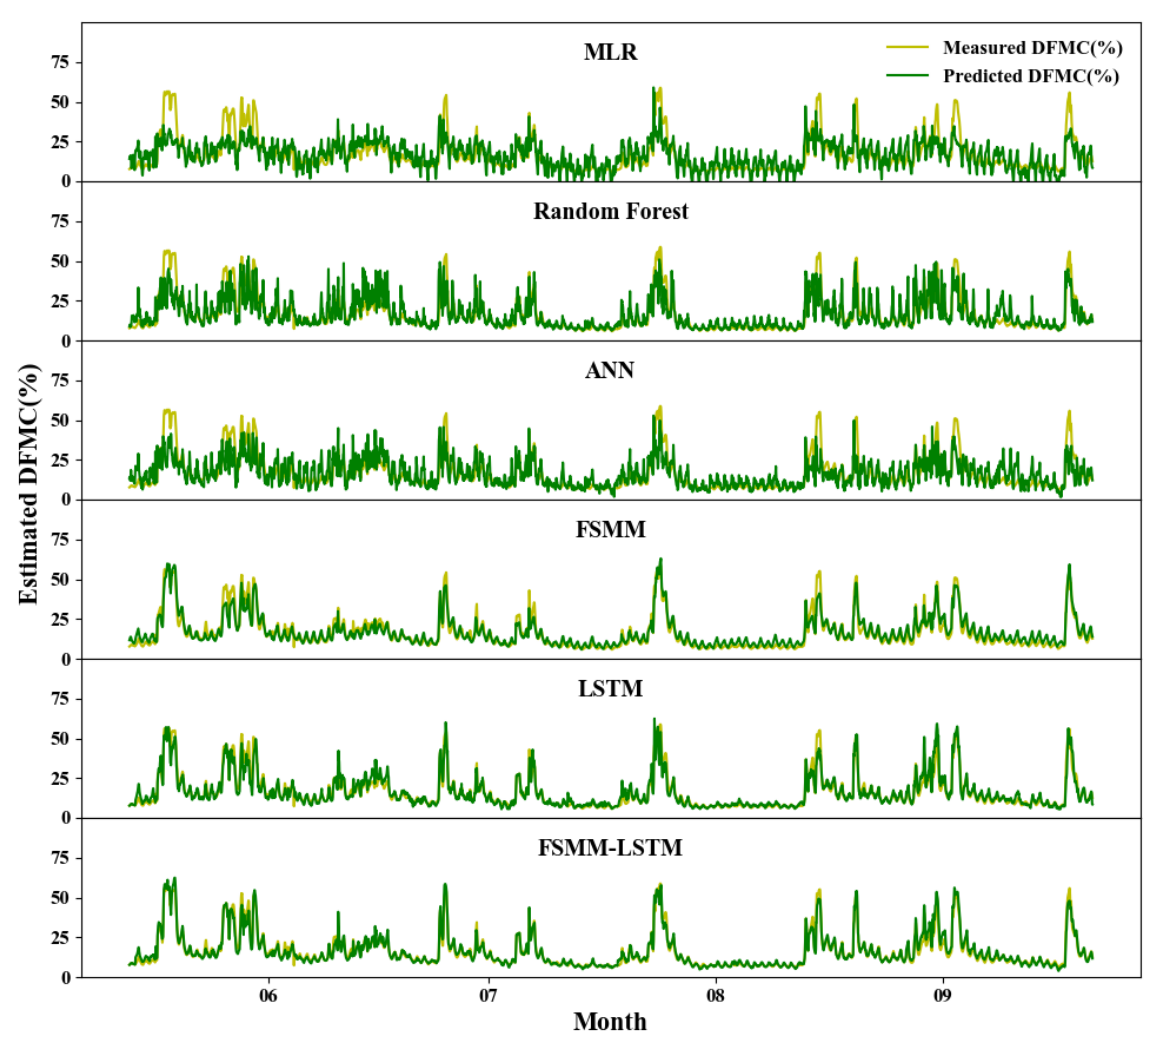
Figure 7. The time series patterns of DFMC predicted by six models, the gold line is measured DFMC and the green line represents predicted DFMC. Table 3. The performance and the time cost of each